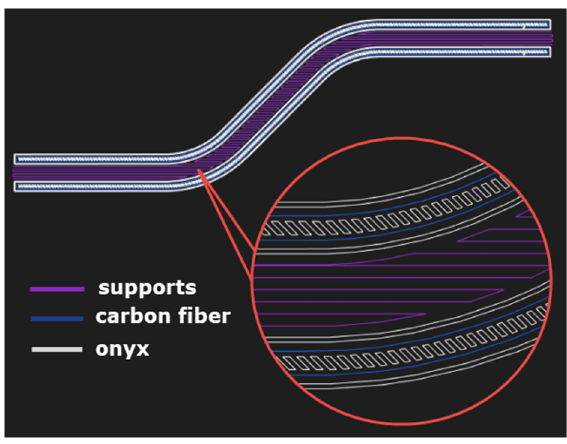
Figure 1. Design of an off-axis hollow CFRP profile.